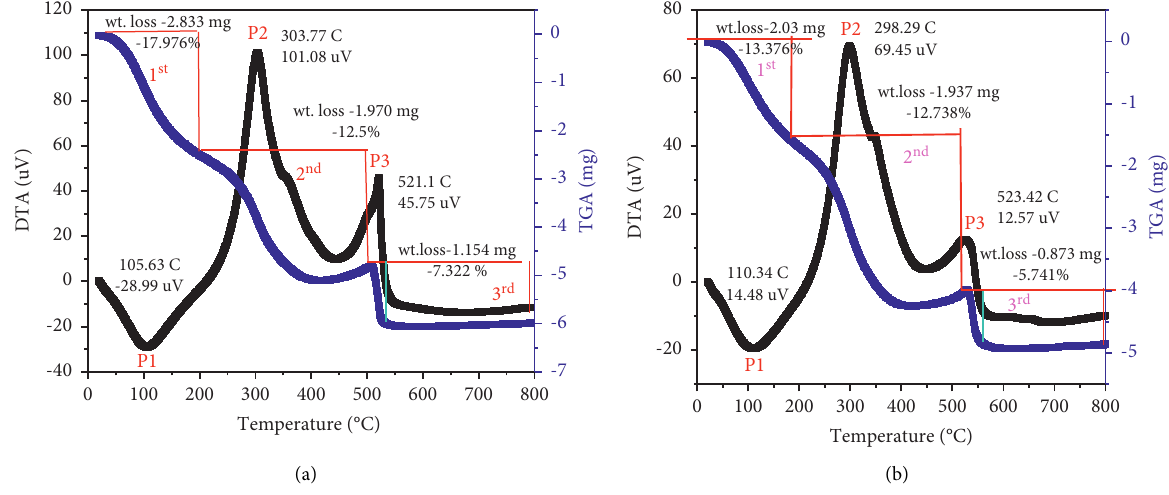
Figure 3: TGA/DTA curve of (a) Citrus sinensis and (b) Musa acuminate mediated synthesis of TiO